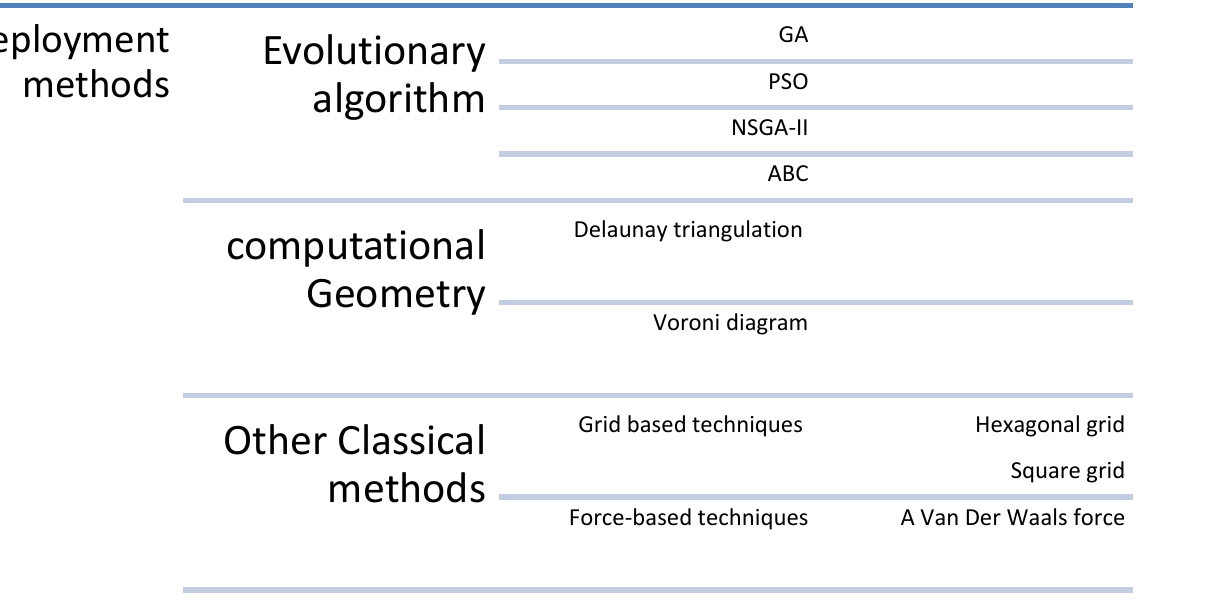
Figure 7. Deployment methods.